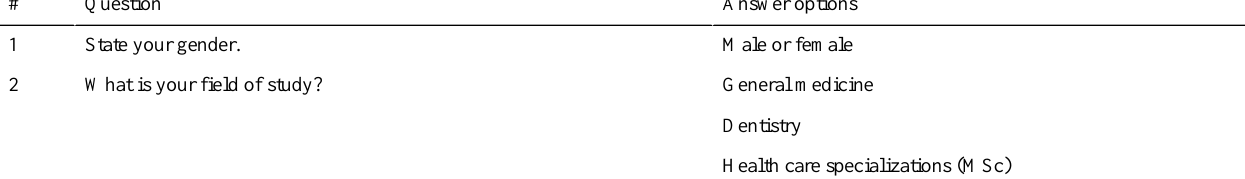
Table 1. Questionnaire for collecting the students’feedback on the interactive